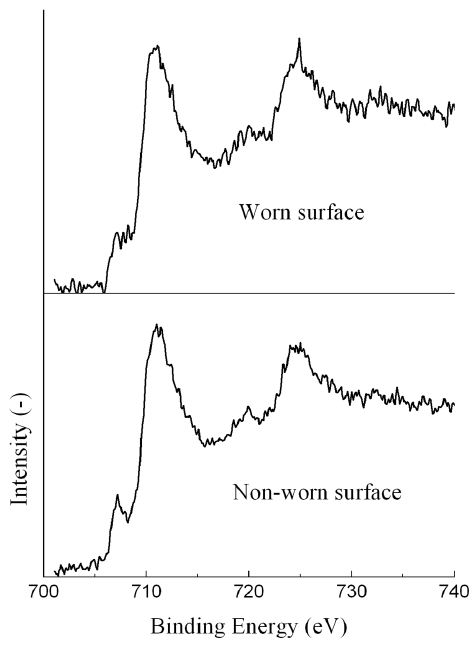
Figure 5. Fe 2p XPS spectra of the ball lubricated with the